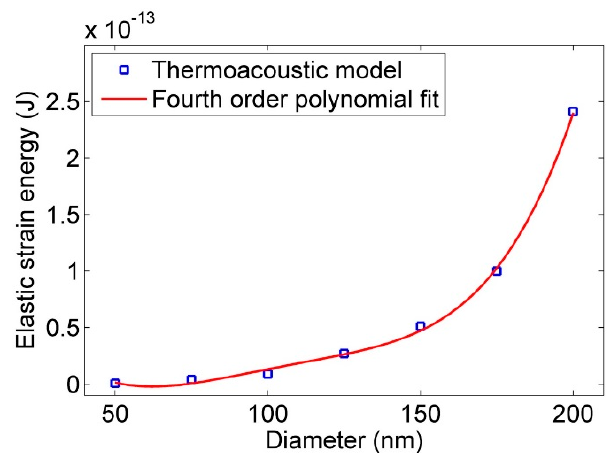
Figure 8. Effect of diameter on the stored strain energy of nanowire. The analytical model matches with the results of the thermoacoustic model ( V ∝ d 4